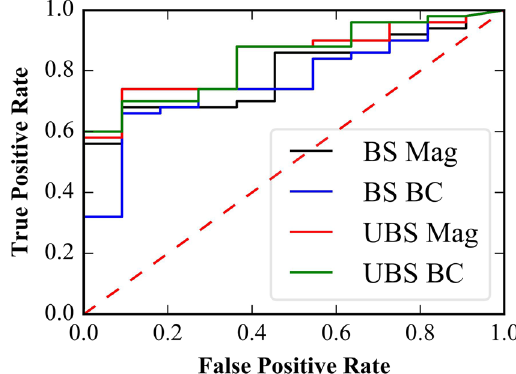
Figure 3. Magnitude of the electrostatic force difference, Δ F rel , can be used to predict whether a mutation is disease-causing. ROC plots are of Δ F rel calculated in the bound state (BS Mag, black line), the component of force difference in the binding direction, Δ F bind,rel , in the bound state (BS BC, blue line), Δ F rel in the unbound (UBS Mag, red line), and Δ F bind,rel in the unbound state (UBS BC, green line). The areas below these four ROC curves are: 0.79, 0.77, 0.84, 0.84, respectively.